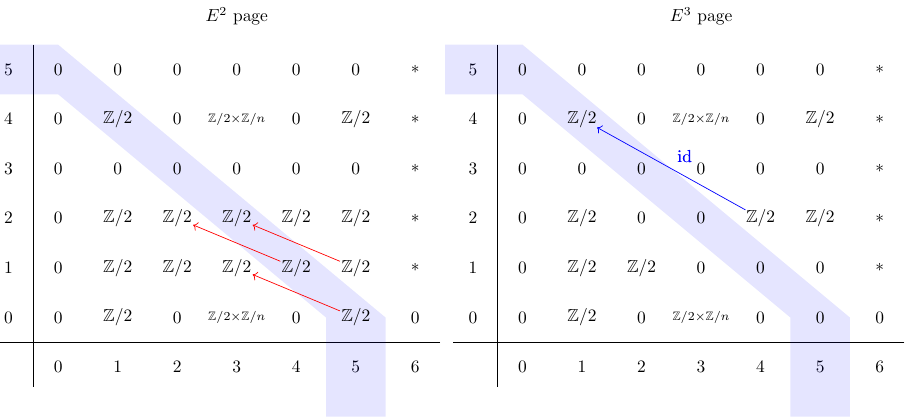
Figure 3. Pages E 2 and E 3 of the AHSS for